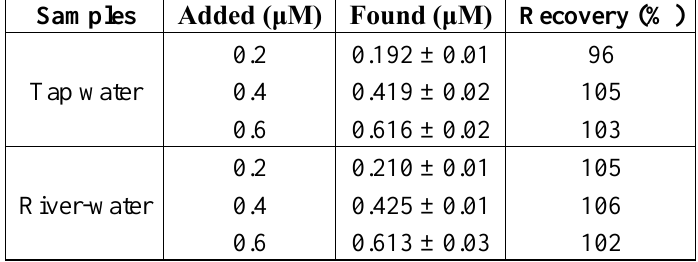
Table 1. Recovery results of Ag(I) added into tap water and river-sample (n = 4 ±